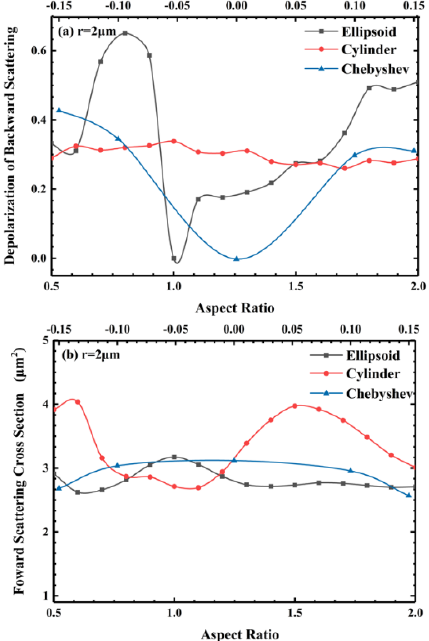
Figure 5. The relation between mean deviation of particle depolarization ratio and particle aspect ratio in receiving angle whose equivalent radius is